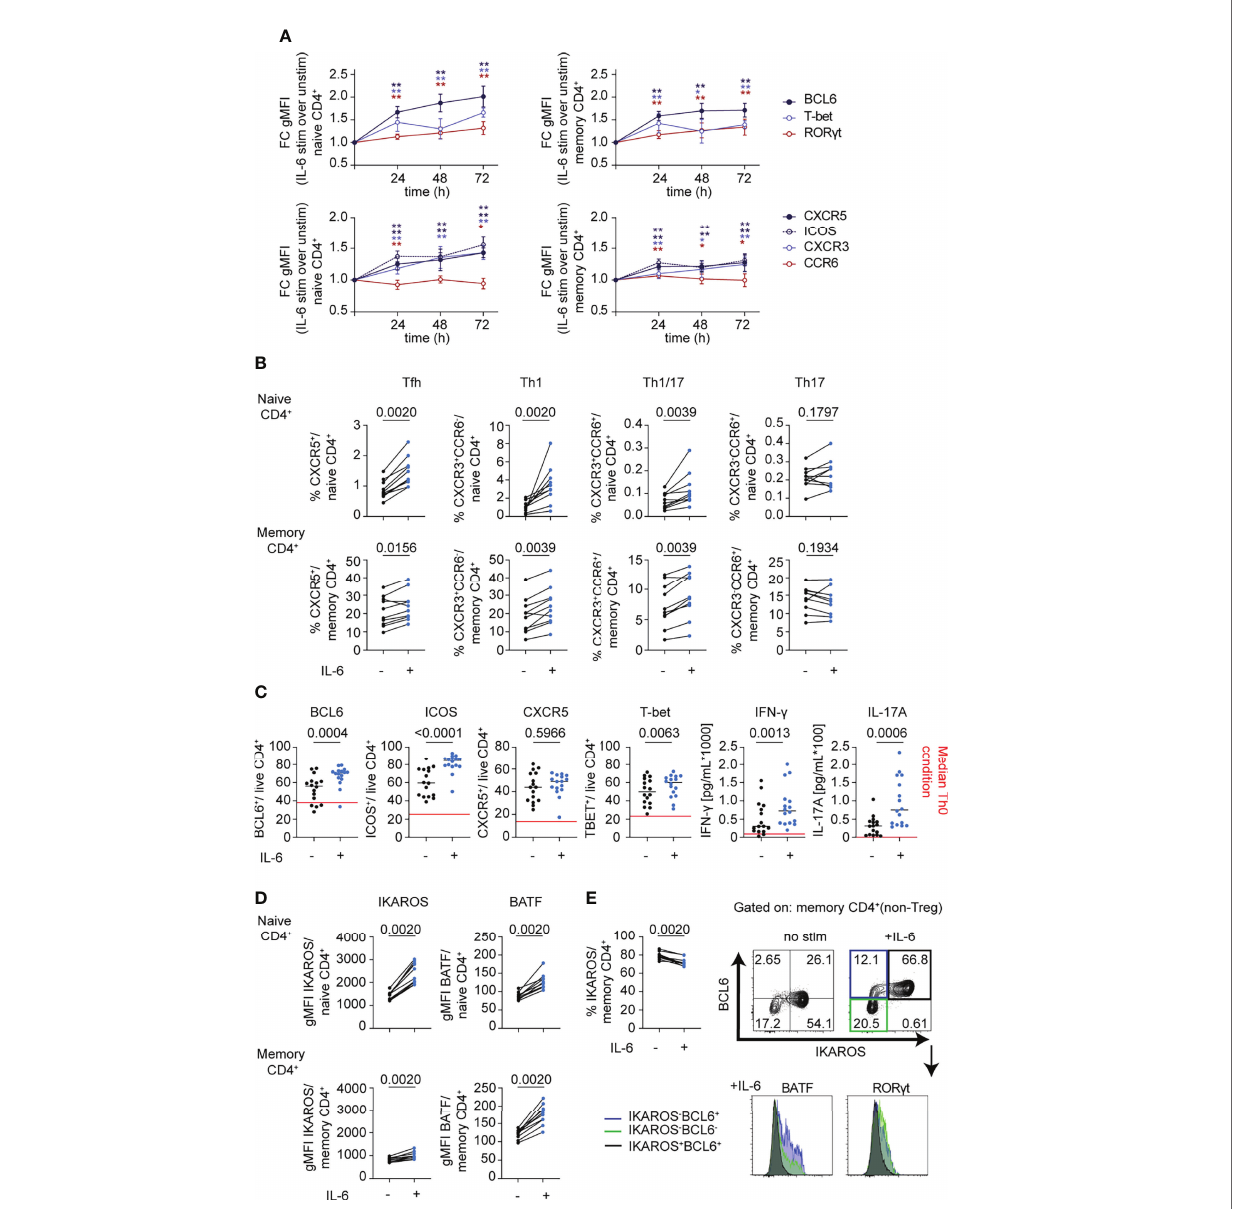
FIGURE 5 | mbIL-6R signaling drives phenotypic changes consistent with features observed in autoimmunity. (A, B, D) CD3-enriched T cells were stimulated with IL-6 (20 ng/mL) or left unstimulated for up to 72 h and the change in expression levels of selected surface and intracellular markers was determined via fl ow cytometry. (A) Fold change in gMFI expression levels of BCL6, ROR g t, and T-bet (top) or of Th-related surface receptors (bottom) in naïve (CD45RA + ) or memory (CD45RA - ) CD4 + (non-Treg) T cells following IL-6 stimulation compared to unstimulated controls over time. (B) Paired analysis of the frequency of gated Th subsets in total naïve (CD45RA + ) or memory (CD45RA - ) CD4 + (non-Treg) T cells in IL-6 stimulated (+) or unstimulated (-) cells after 72 h of culture. (C) Naïve (CD45RA + ) CD4 + T cells were cultured in conditions used to differentiate both Tfh and Th17 cells (IL-1 b , IL-2, IL-23, TGF- b , a -CD3/CD28) in the presence (+) or absence (-) of IL-6 (20 ng/mL) for 5 days and changes in surface (CXCR5, ICOS) or intracellular markers (BCL6, T-bet) were determined via fl ow cytometry on gated live CD4 + T cells. Changes in cytokines from culture supernatants were detected by Luminex assay. Red line indicates median levels measured in Th0 conditions. (D) gMFI expression levels of BATF and IKAROS in gated naïve (CD45RA + ) or memory (CD45RA - ) CD4 + (non-Treg) T cells in IL-6 stimulated (+) or unstimulated (-) cells after 72 h of culture. (E) Frequency of IKAROS + in memory CD4 + T cells as in (D) and representative fl ow plot of BCL6 and IKAROS expression in memory CD4 + T cells (top) and histogram of expression levels of BATF and ROR g t among gated subsets de fi ned by IKAROS and BCL6 expression. (A) Wilcoxon matched-pairs signed rank test comparing IL-6 stimulation to unstimulated control condition for each sample and each time-point. *p < 0.05, **p < 0.01 (B – E) Wilcoxon matched-pairs signed rank test. (A, B, D, E) n = 10. (C) . n =